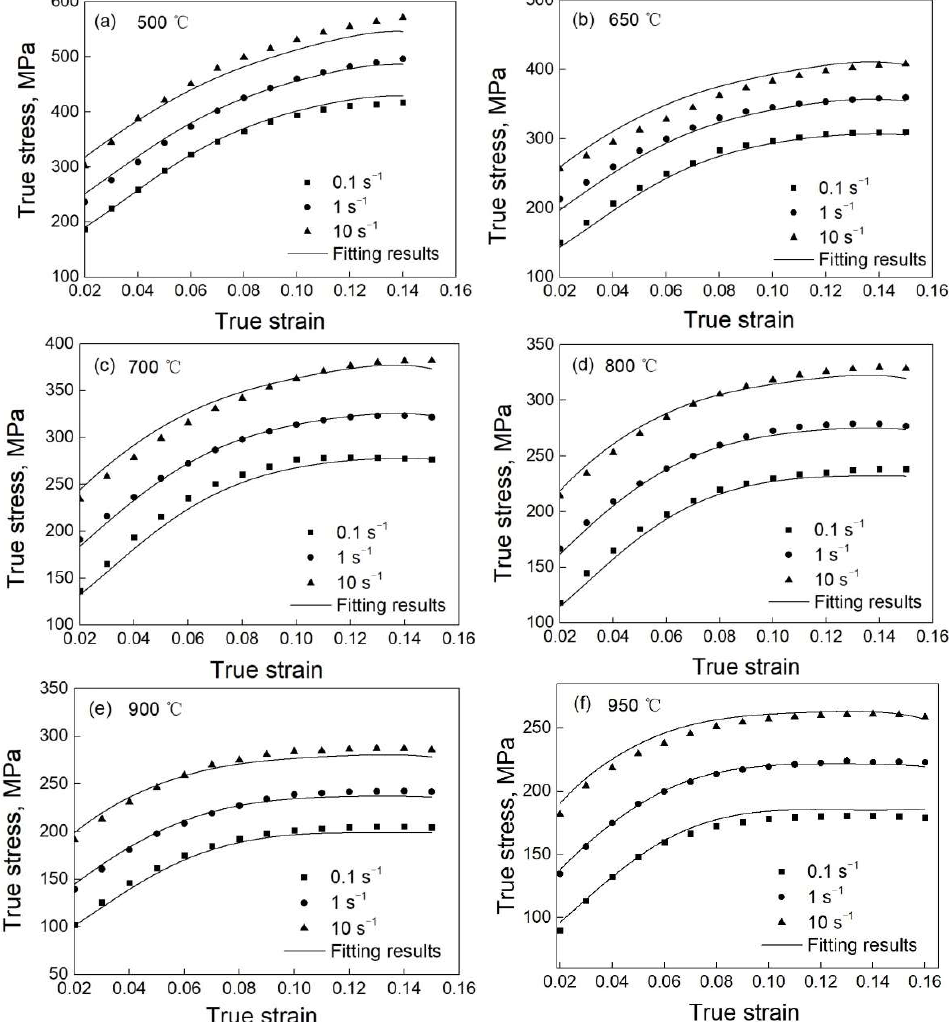
Figure 16. Comparison between constitutive fitting results and experimental results: ( a ) 500 °C; ( b ) 650 °C; ( c ) 700 °C; ( d ) 800 °C; ( e ) 900 °C and ( f ) 950 °C.